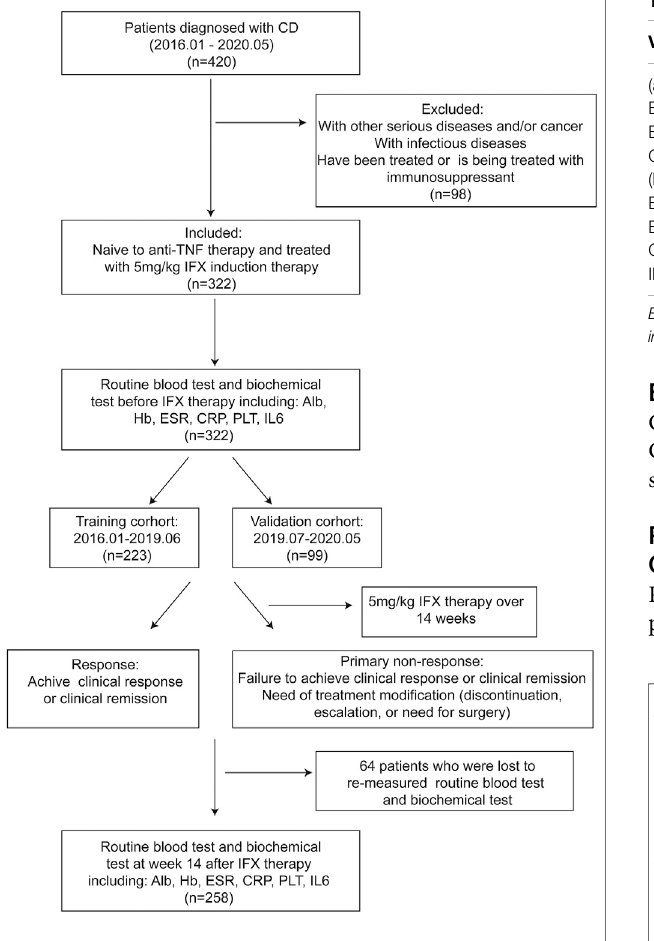
FIGURE 1 | Flow diagram of the study design.